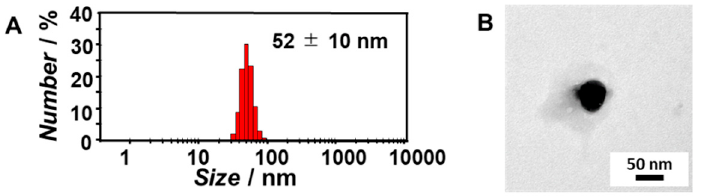
Figure 5. ( A ) Size-distributions obtained from DLS and ( B ) TEM images for co-assembly peptides